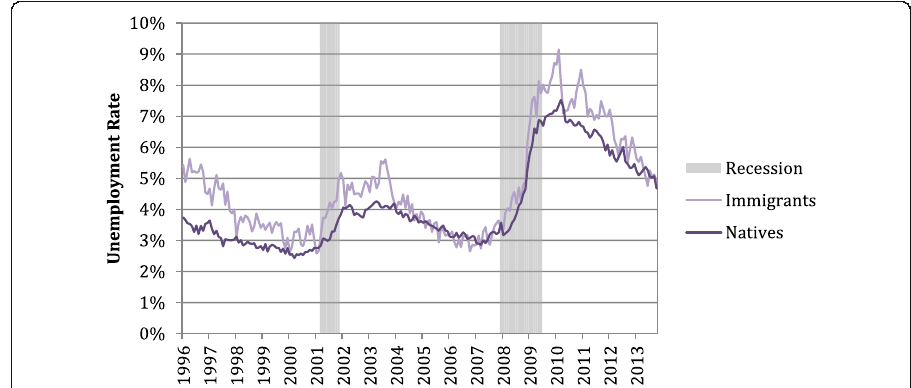
Fig. 1 Seasonally adjusted monthly unemployment rates: Matched CPS data, 1996 – 2013. Notes: Monthly unemployment rates are calculated by author using the matched CPS data. All data are seasonally adjusted. The sample consists of people aged 20 – 64 who are in the labor force for any two consecutive months. Shaded area represents recessions as reported by the National Bureau of Economic Research (NBER)